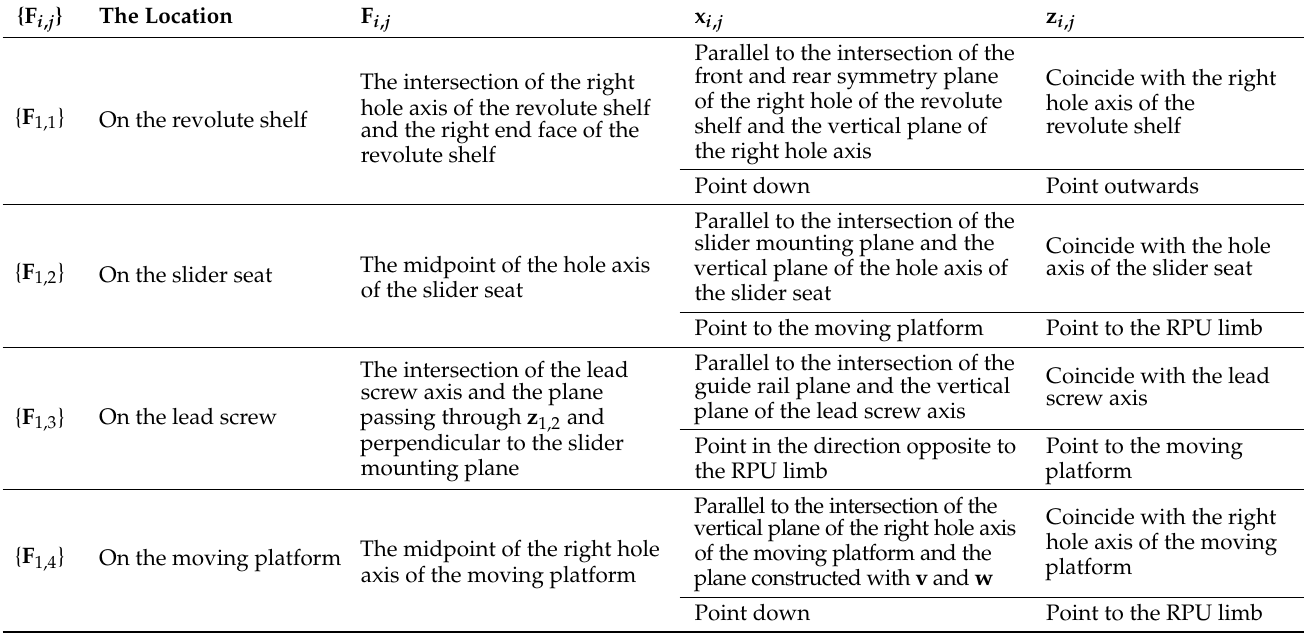
Table 1. Definitions of local coordinate systems for the first UPR limb.